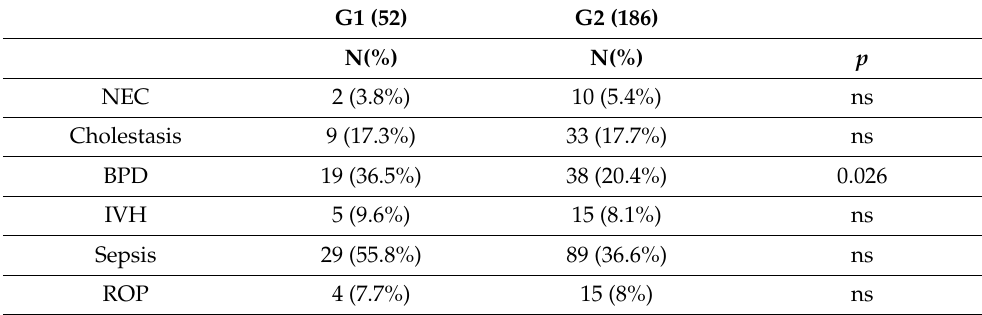
Table 2. Comorbidities. NEC, necrotizing enterocolitis; BPD, pulmonary bronchodysplasia; IVH, intraventricular hemorrhage; ROP, retinopathy of prematurity. G1, subjects at increased risk of metabolic bone disease. G2, subjects with standard risk of metabolic bone